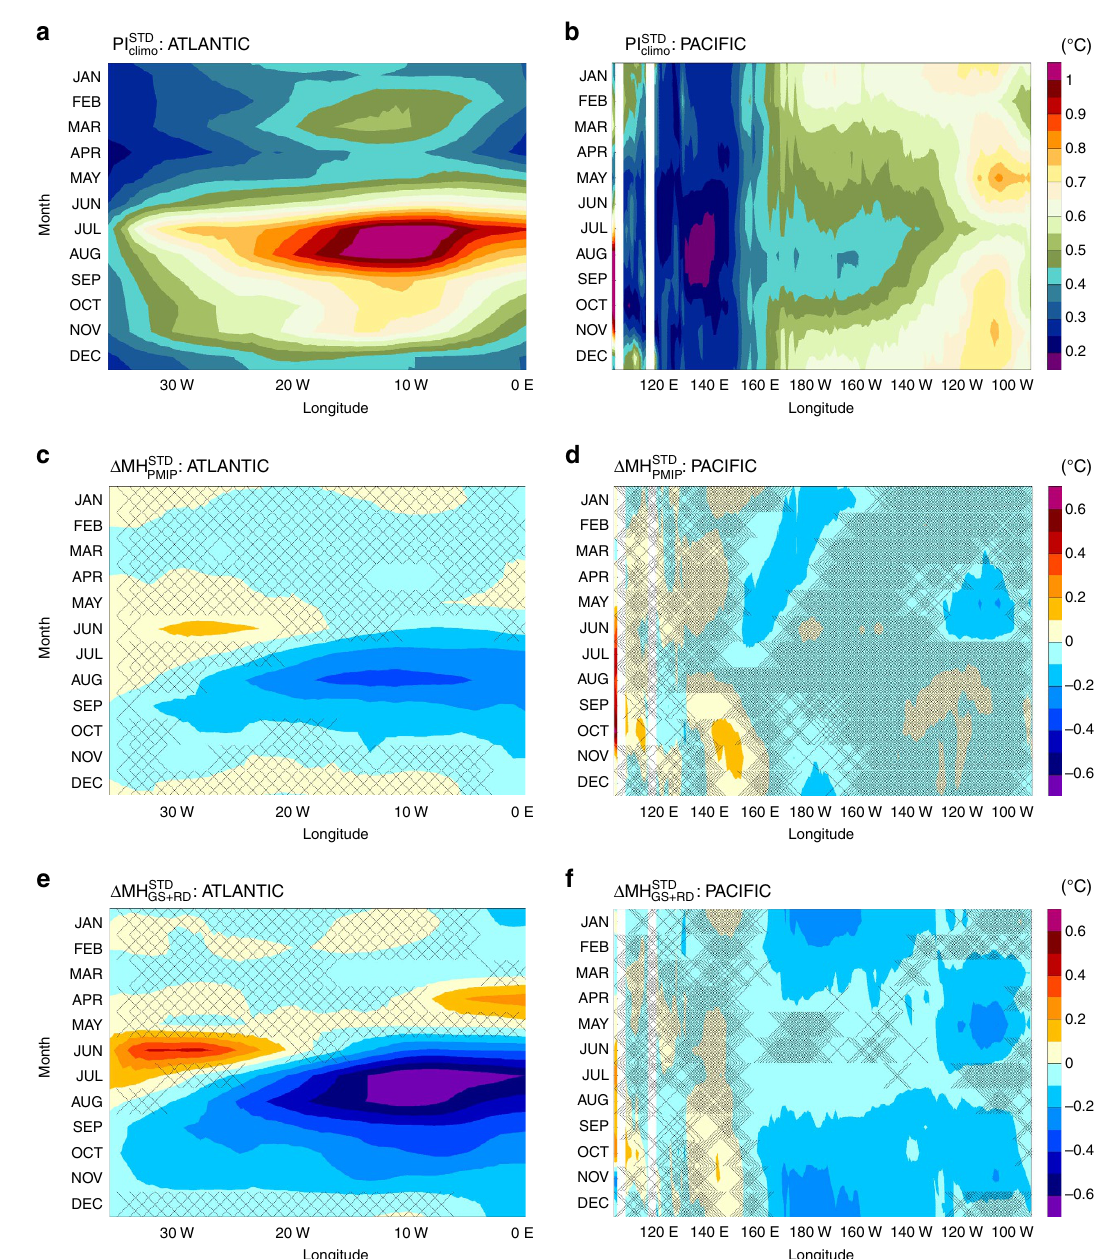
Figure 2 | Equatorial Atlantic and Pacific longitudinal transect of the monthly average SST standard deviations for the PI simulation and the changes in the MH experiments. ( a ) Longitudinal transect of the climatological monthly SST standard deviation for the equatorial Atlantic (3 (cid:2) S–3 (cid:2) N) and ( b ) Pacific (5 (cid:2) S–5 (cid:2) N) for each month; and ( c , d ) their changes in SST standard deviation in the MH PMIP and ( e , f ) MH GS þ RD experiments for the two regions. Hatched areas reflect regions in which the changes are not significant at the 95% confidence level assessed using a two-sided t